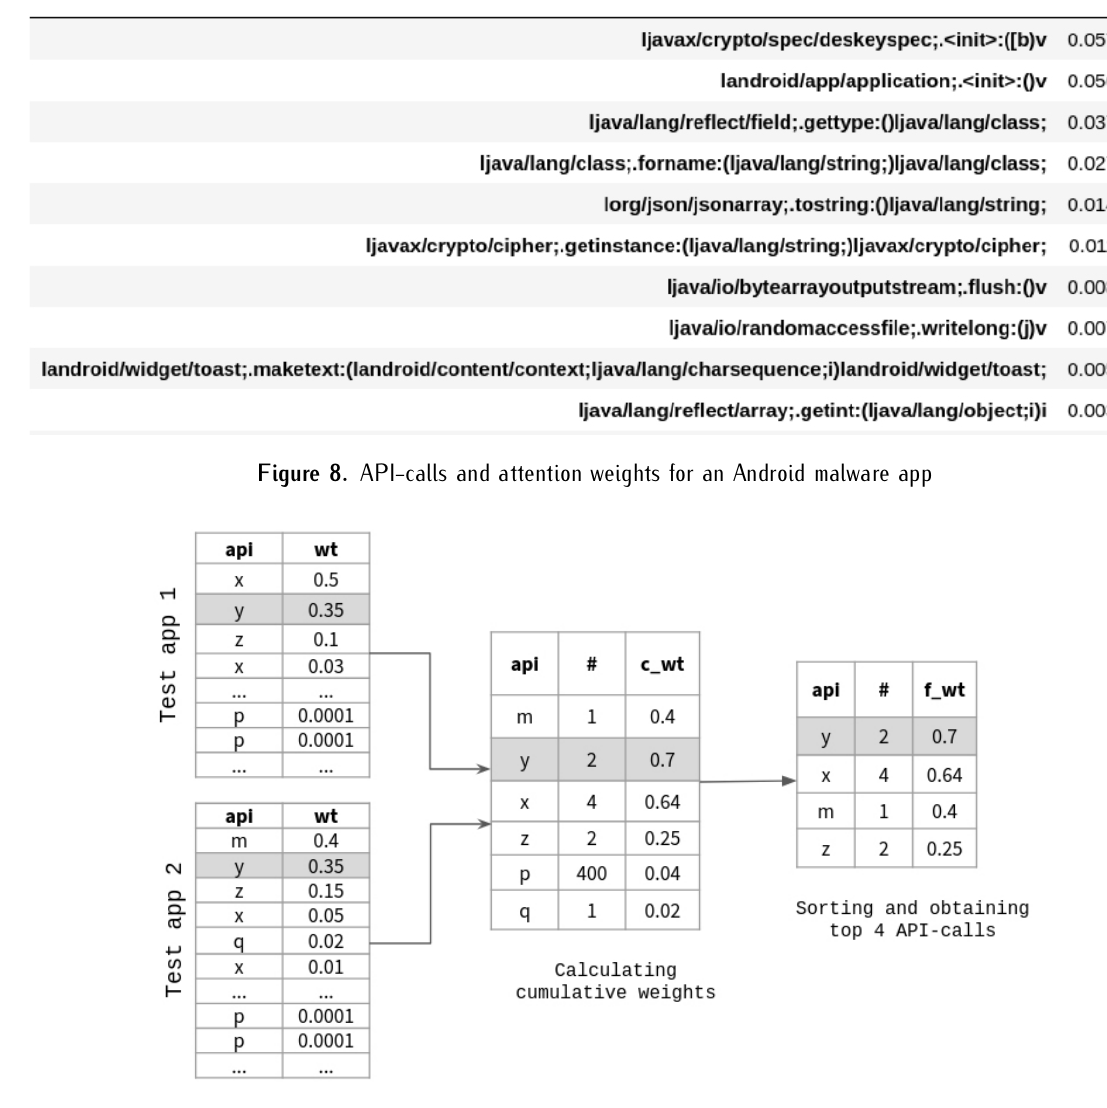
Figure 9. Top feature selection strategy: For the sake of readability, here we illustrate the selection process with a tiny set of two apps whereas the goal is to identify only top 4